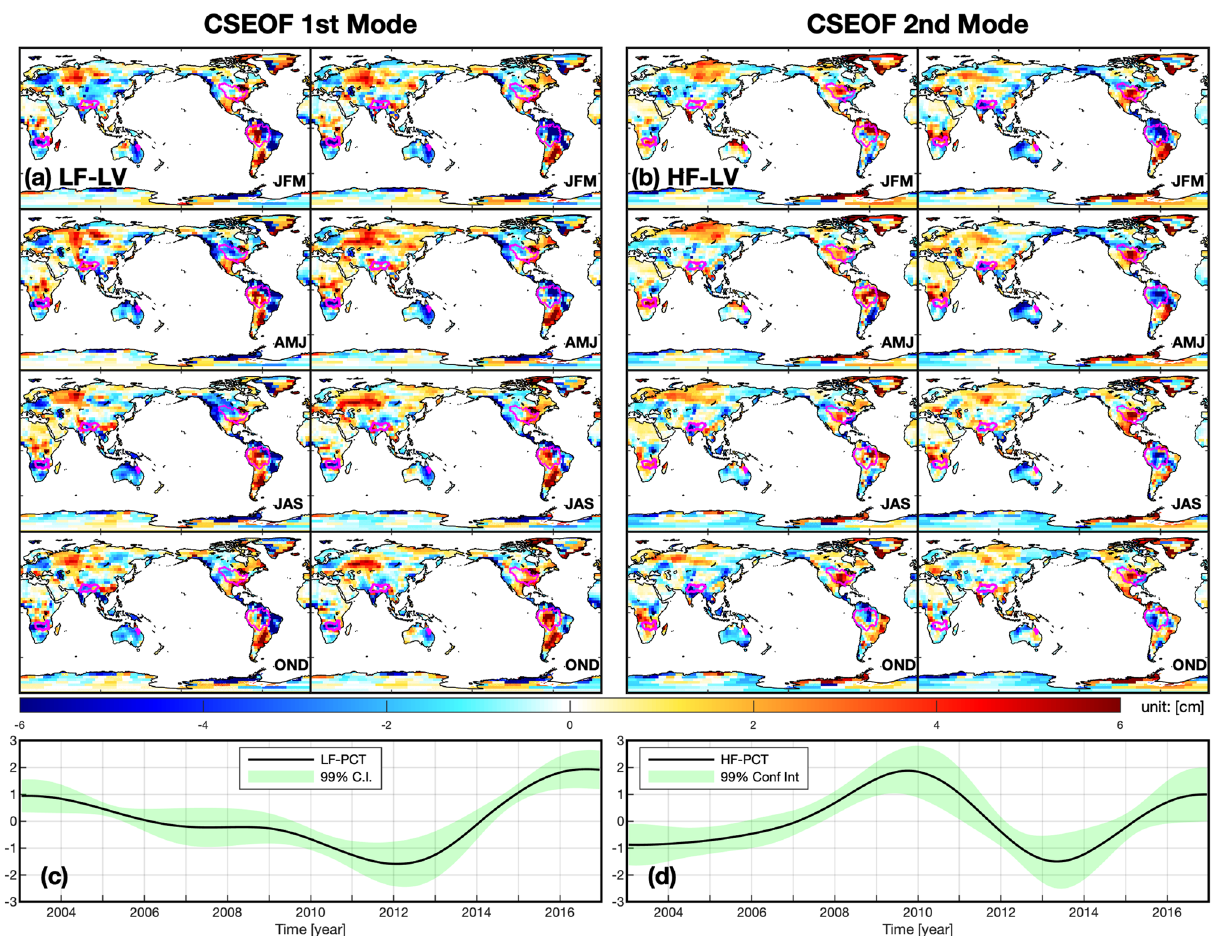
Figure 2. The dominant modes of the CSEOF analysis of GRACE: ( a ) LV of low-frequency mode (3 months averaged), ( b ) LV of high-frequency mode (3 months averaged), ( c ) PCT of low-frequency mode, and ( d ) PCT of high-frequency mode; the magenta-colored lines on the maps are five river-basins; see Figs. S5 and S6 for original LVs. The maps and graphs were created using MATLAB (version R2020b; https:// www. mathw orks. com/ produ cts/ matlab.